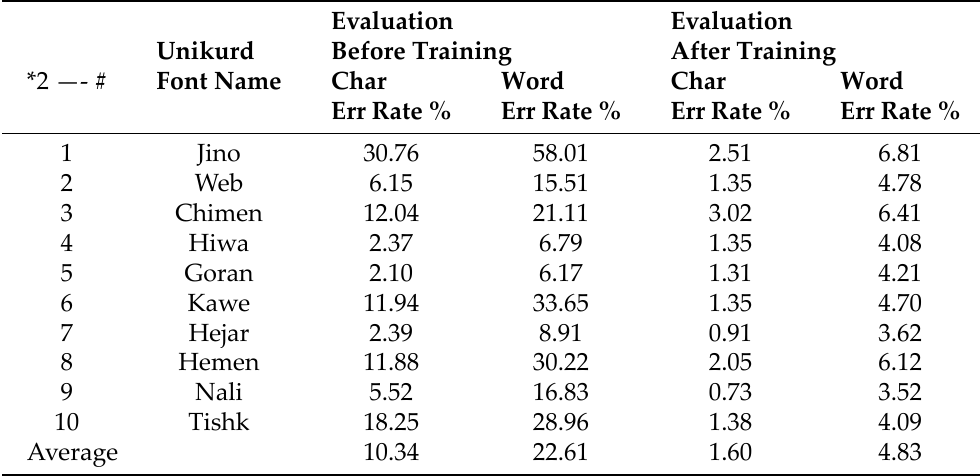
Table 12. The evaluation result of training/fine‑tuning for adding new fonts.